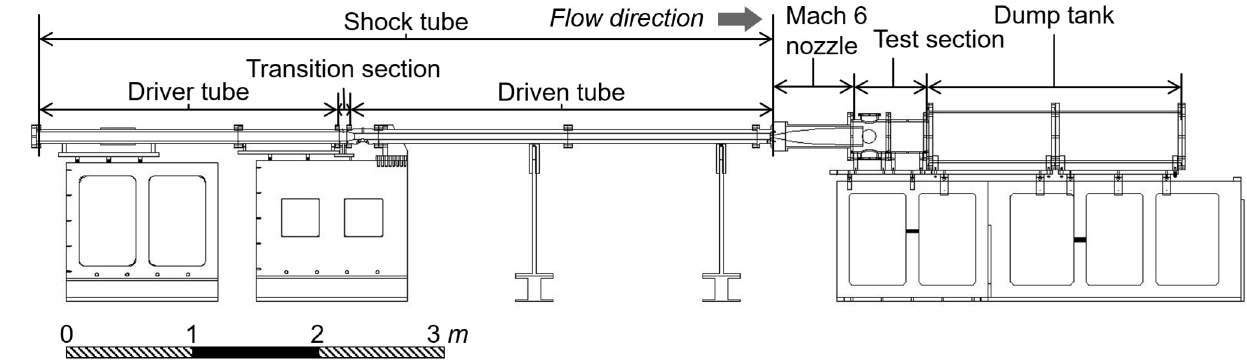
Fig 1. Schematic of K1 shock